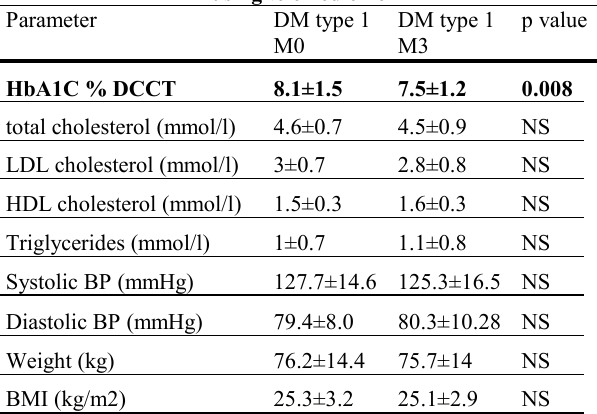
Table 2. Description of characteristics (mean ± SD) in DM type 1 participants before (M0) and 3 months (M3) after start